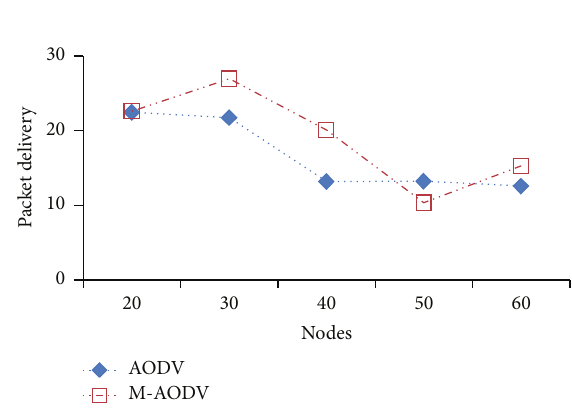
Figure 7: Packet delivery under wormhole attack.